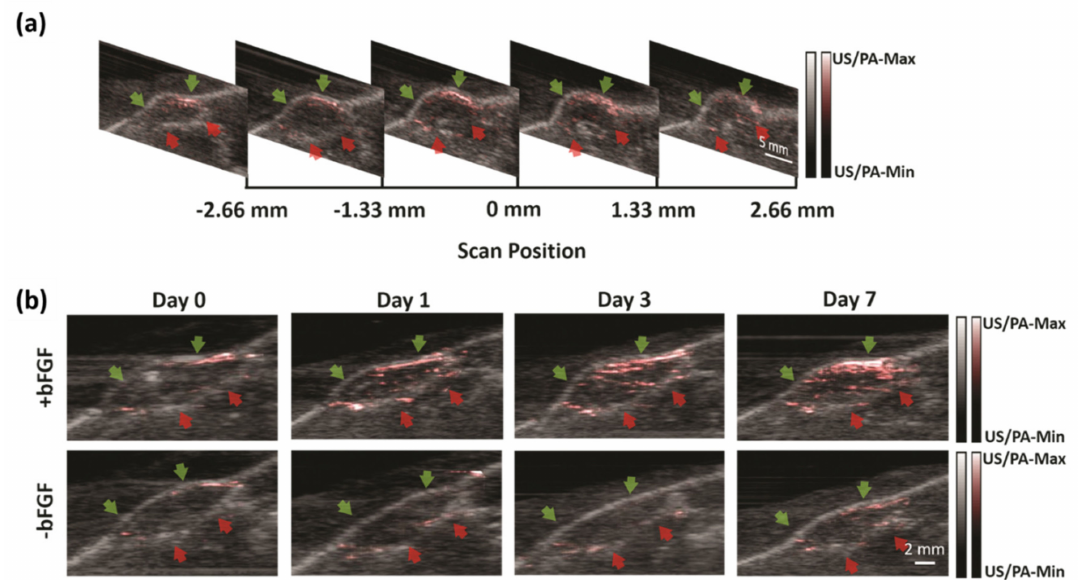
Figure 5. Longitudinal LED-based PA-US imaging of two subcutaneous implants. Green and red arrows indicate the upper and lower edges of the sca ff old, as determined through the B-mode US. ( a ) A series of two-dimensional US-PA images from a + bFGF sca ff old on day 7 at di ff erent scan positions. Note that only images within the range of − 2.5 to 2.5 mm are used for MIP image. ( b ) A series of longitudinal MIP US-PA images of + bFGF and − bFGF sca ff olds from the same mouse. PA intensity represented in red has the greatest di ff erence on day 7. Reprinted from Ref.